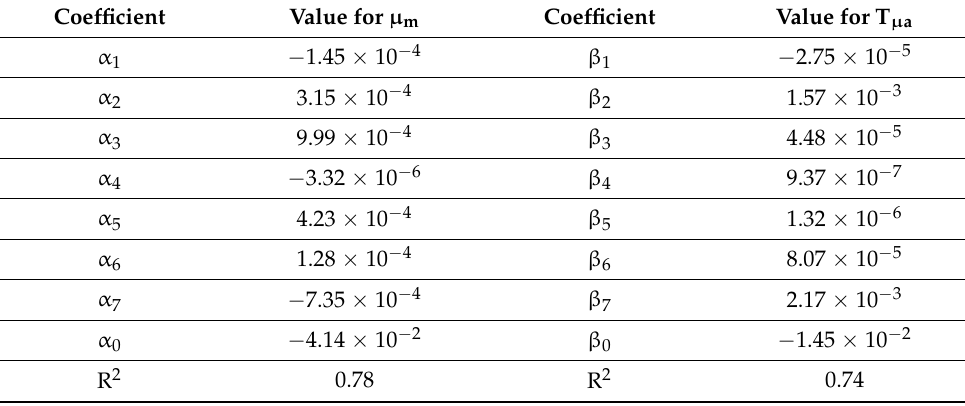
Table 6. Multiple regression